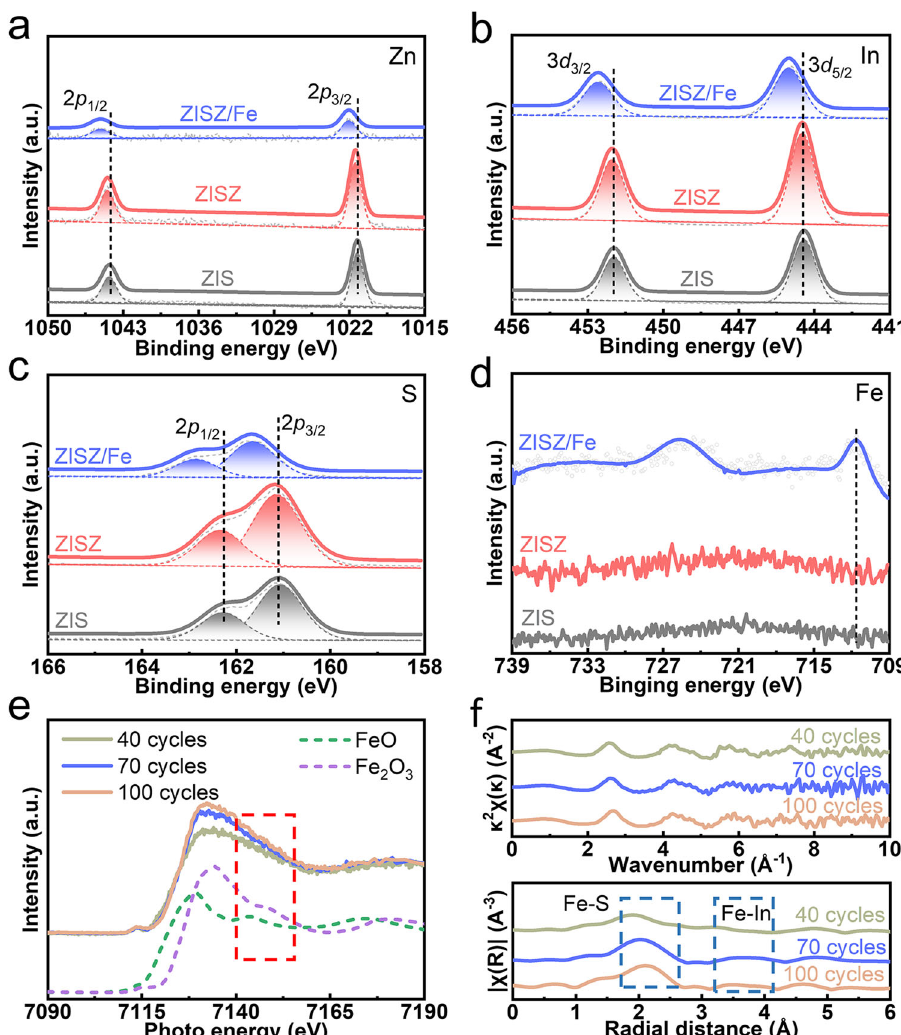
Fig. 2 Characterizations of photoanodes. a Zn 2 p , b In 3 d , c S 2 p , and d Fe 2 p XPS of ZIS, ZISZ, and ZISZ/Fe. e The Fe K-edge XANES spectra. f The Fe K-edge EXAFS as functions k 2 χ (k) and FT-EXAFS of ZISZ/Fe with different ALD cycles (40, 70, and 100 cycles); k = wave vector and χ (k) = oscillation as a function of the photoelectron